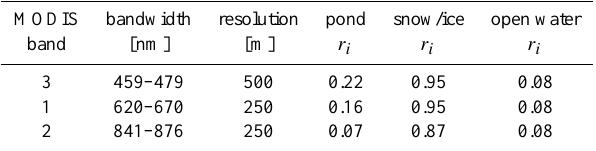
Table 1. Spectral reflectances ( r i ) of surface types used in the un- mixing algorithm (after Tschudi et al.,